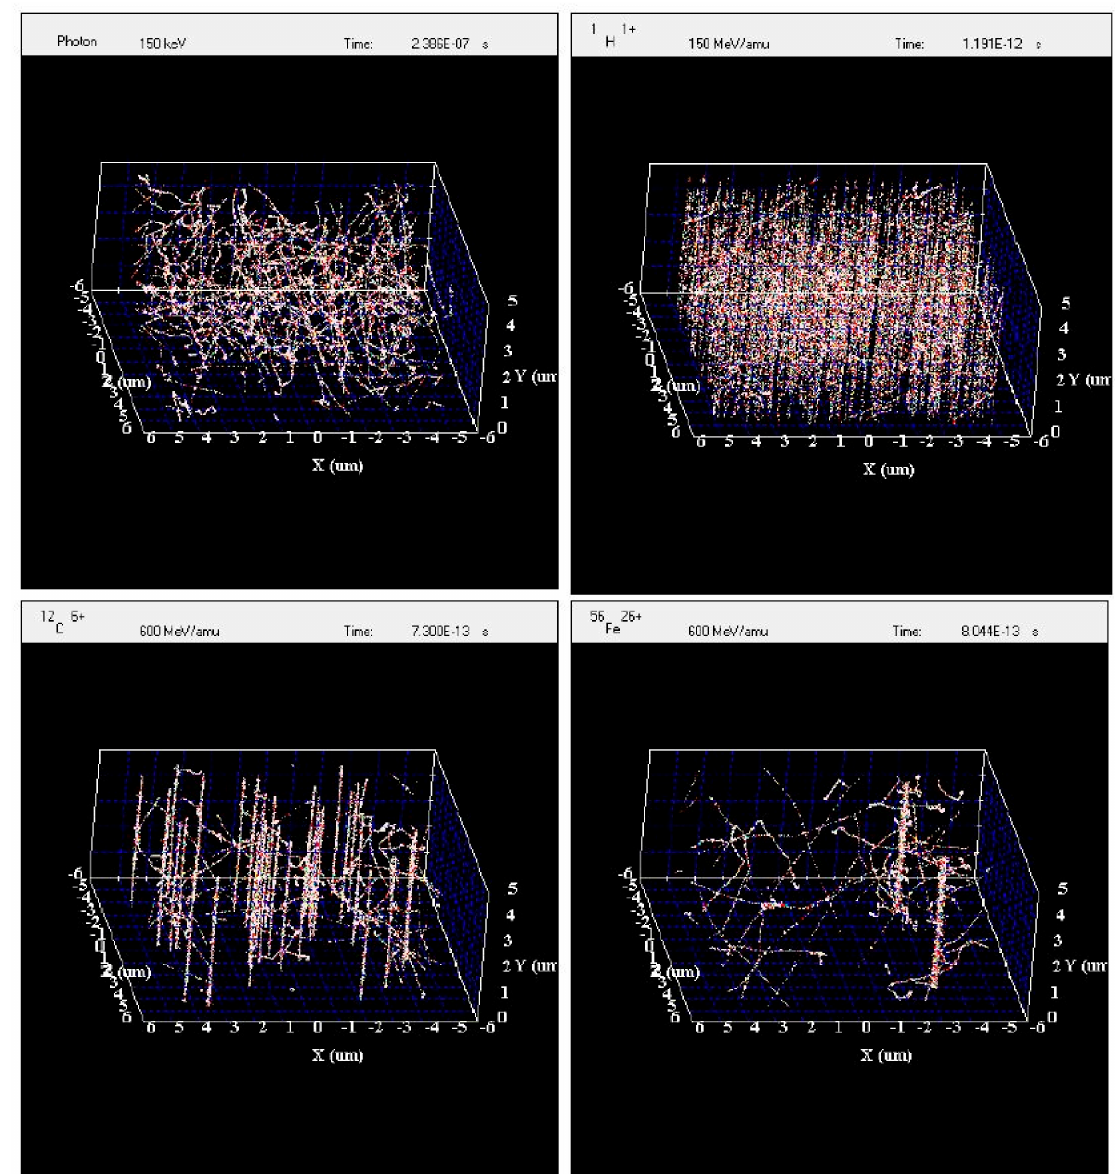
Figure 6. Simulation of the irradiation of a volume by 137 Cs photons, 150-MeV protons, 600 MeV/n carbon ions, and 600 MeV/n iron ions. In all cases, the dosage to the irradiated volume is ~0.5